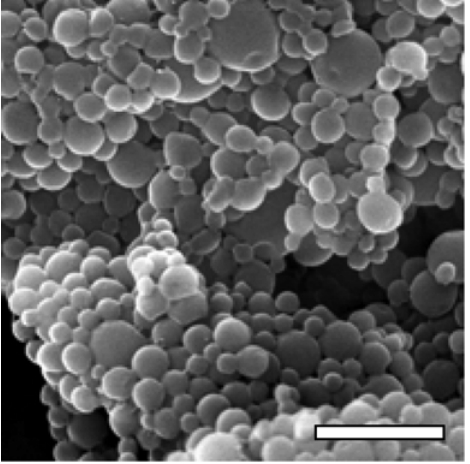
Figure 4. Scanning electron micrograph of PLGA nanoparticles produced in a contact-free flow-through ultrasonication cell (bar is 1 µm). Reprinted with permission from ref.